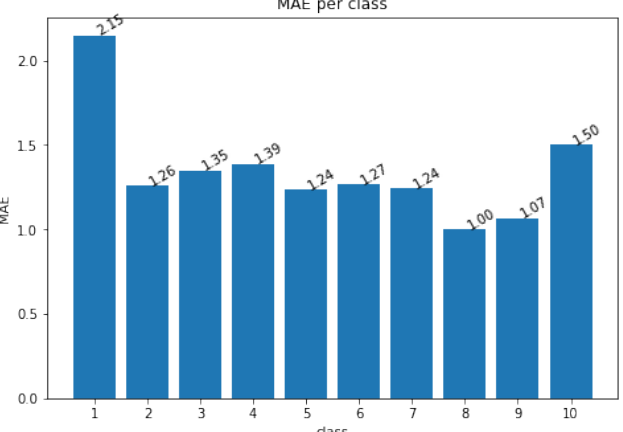
Figure 6. MAE per class of Culex Italy case using both EO and entomological data.